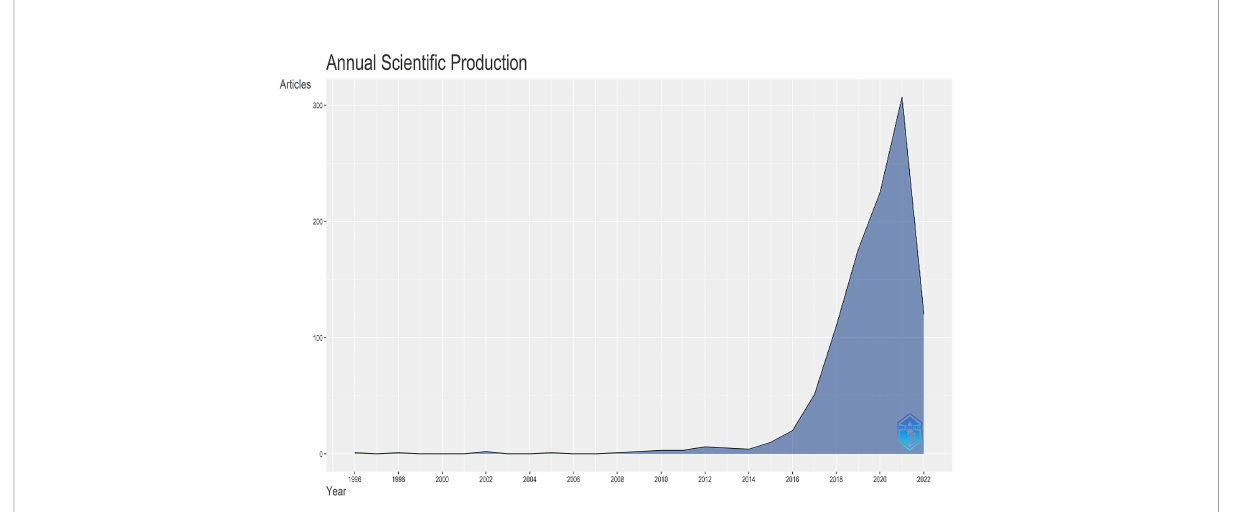
FIGURE 1 The annual scienti fi c production in the research